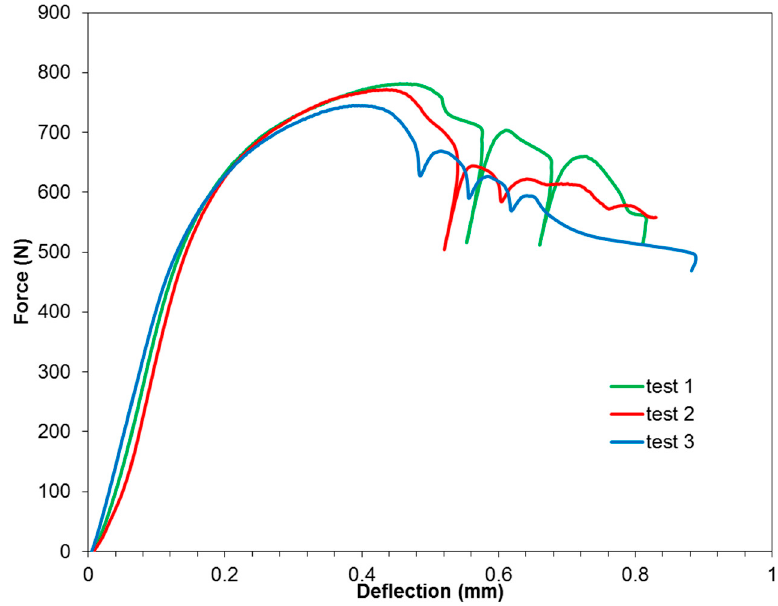
Figure 22. The load–deflection curves of 3/2 lay-up specimens.